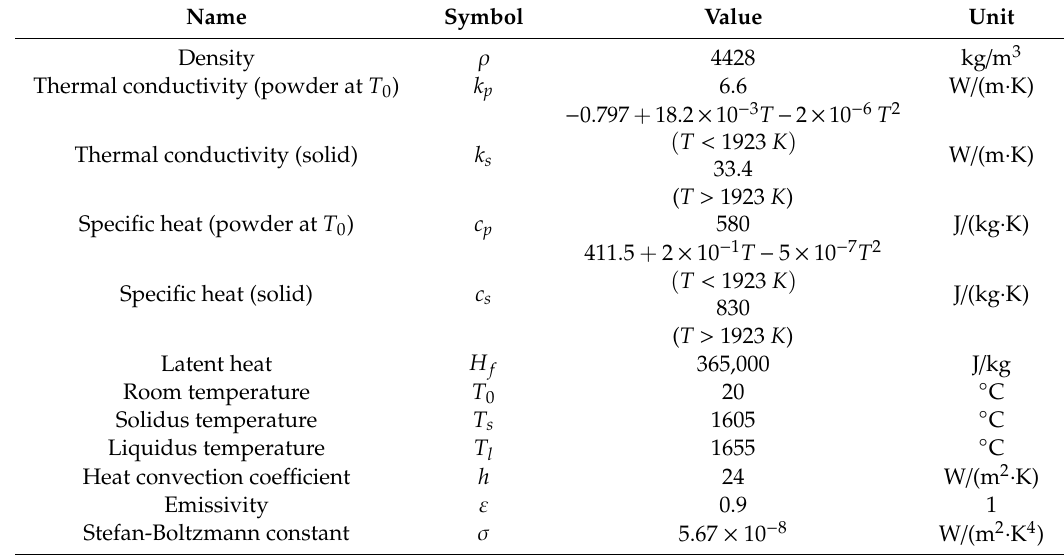
Table 1. Materials properties and thermophysical properties of Ti6Al4V [12,42–44].